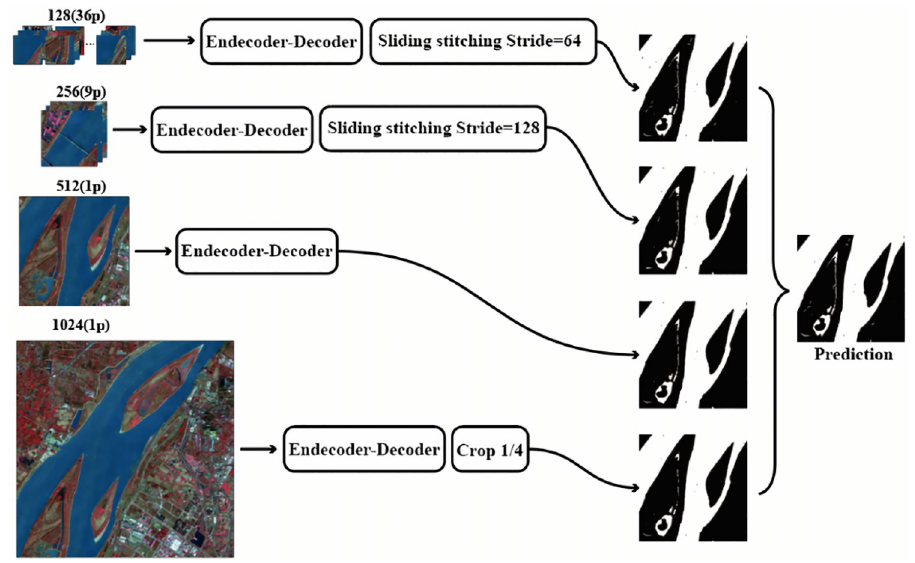
Fig 7. The data input of various sizes is processed and then spliced into a uniform size label diagram. Reprinted from www.gscloud.cn under a CC BY license, with permission from Dr. Qinghui Lin, original copyright 2019.